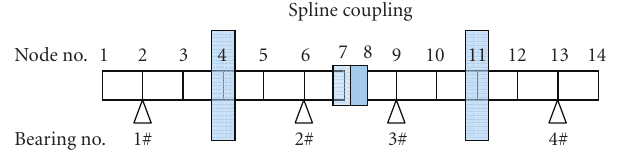
Figure 10: Sketch map of rotor-spline coupling system.